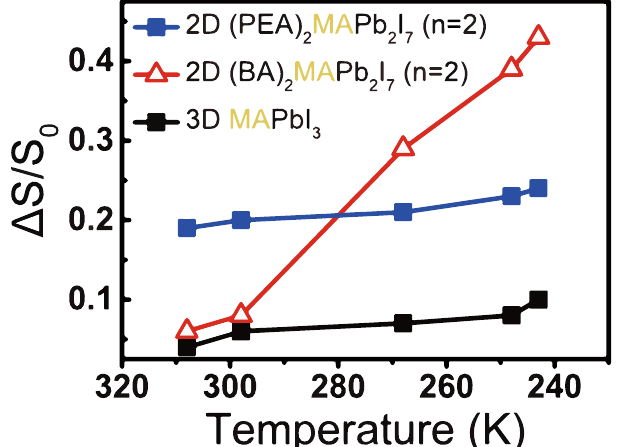
Fig. 3 The temperature-dependent 13 C{ 15 N}REDOR dephasing ( Δ S/S 0 ) of 13 C, 15 N-MA incorporated in different materials. The Δ S/S 0 of MA peak in 2D (PEA) 2 ( 13 C, 15 N-MA)Pb 2 I 7 ( n = 2) (blue solid squares), 2D (BA) 2 ( 13 C, 15 N-MA)Pb 2 I 7 ( n = 2) (red open triangles)* and 3D ( 13 C, 15 N- MA)PbI 3 (black solid squares) at the dephasing time of 2.4 ms. *The data were obtained from the major MA peak of 2D (BA) 2 ( 13 C, 15 N-MA)Pb 2 I 7 ( n =